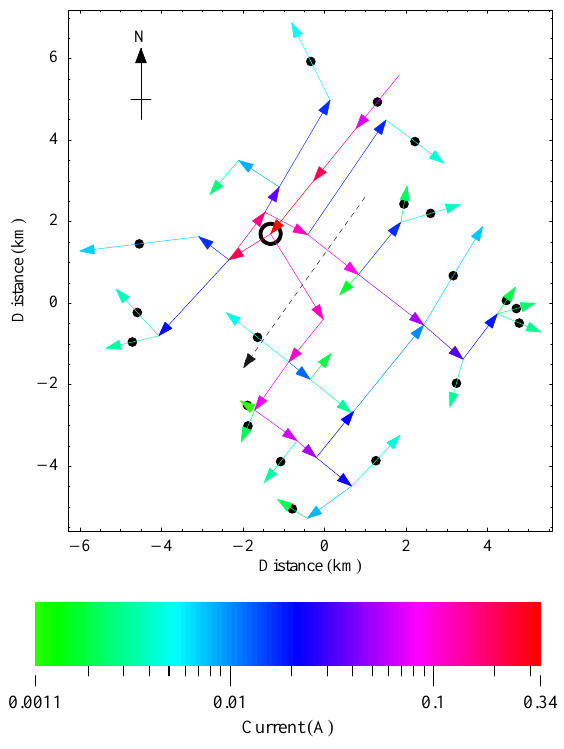
Fig. 3. Our scale model of the Outram network. Each line rep- resents an electrical transmission line, with arrows indicating the sense and direction of the current phase relative to the injection cur- rent located at the circle. The black dots indicate terminating ca- pacitors. The dashed line is the dipole approximation of the Outram network. Compare with Fig. 1, where the Outram sub-network lies on the far left of the Dunedin